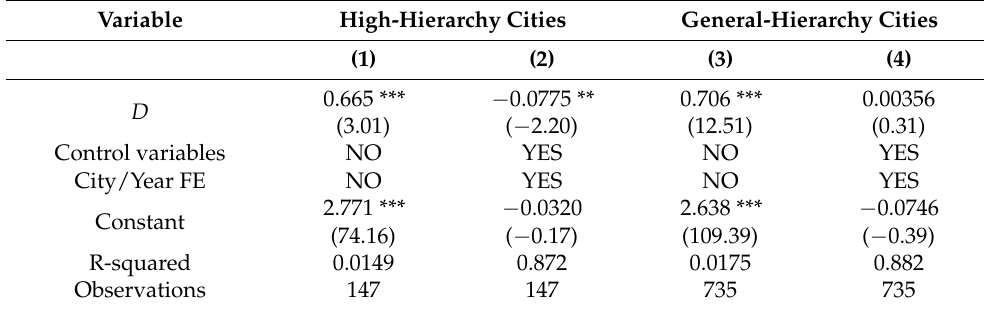
Table 7. Heterogeneity of effects in different